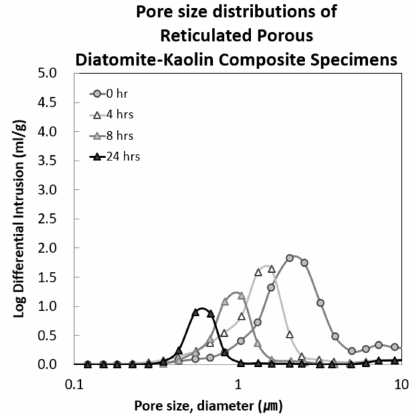
Figure 5. Pore size distributions of reticulated porous diatomite–kaolin composites prepared from diatomite–kaolin composite particles ball milled for 0, 4, 8, and 24